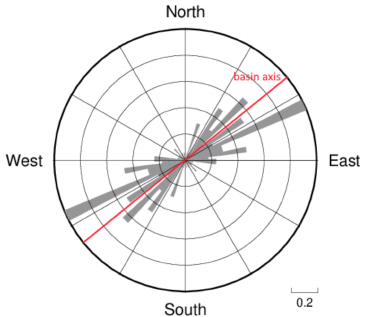
Figure 4. Rose diagram of ray path azimuths showing the striking directions of the higher modes. The red line indicates the basin